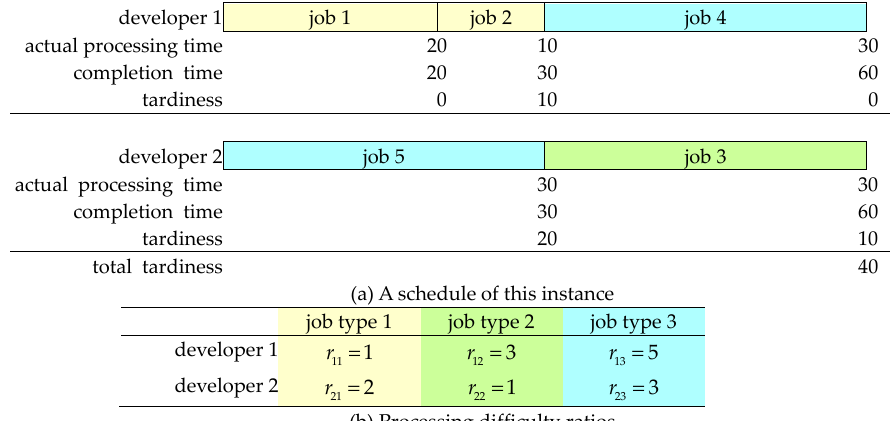
Figure 1. A problem instance.